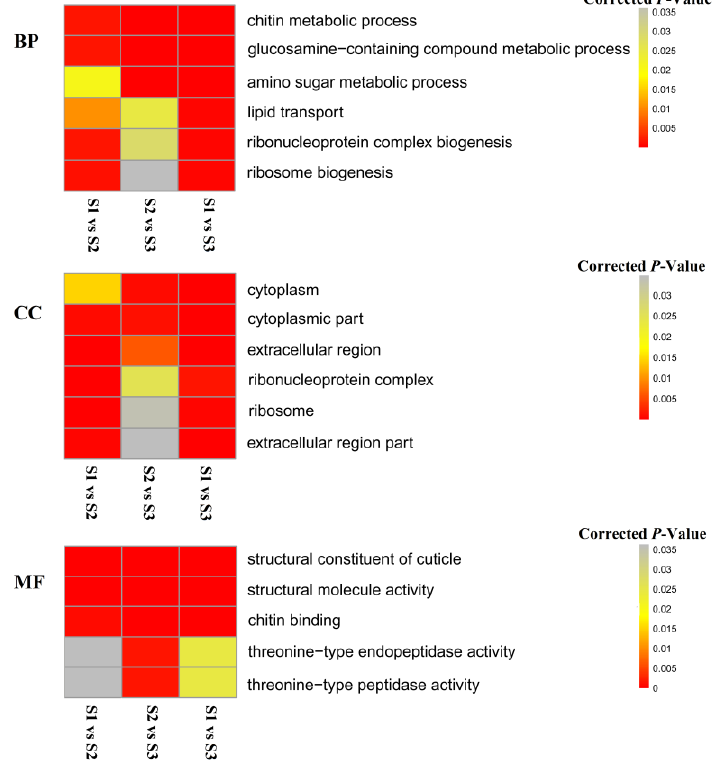
Figure 4. GO (genomic theory database) enrichment analysis of DEGs. BP, Biological Process; CC, Cellular Component; MF, Molecular Function. Corrected p -Value < 0.05 represents enrichment, the smaller the p -Value, the closer the color is to red and the more significant the enrichment.